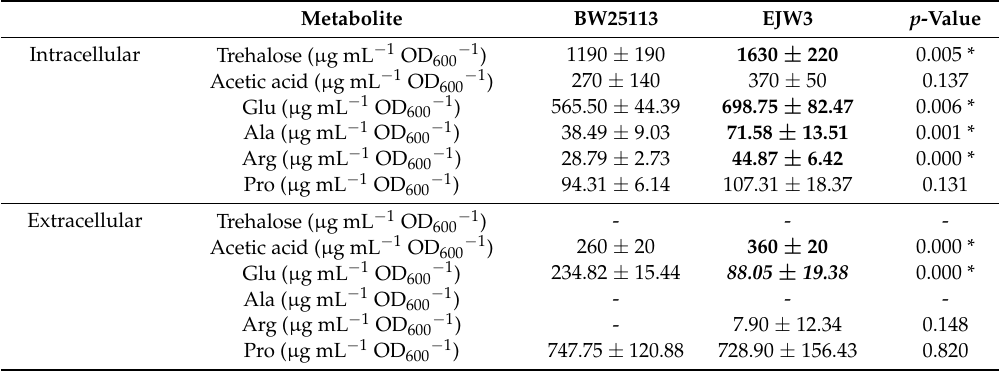
Table 5. Quantification of intracellular and extracellular metabolites in M9 supplemented with 0.6 M